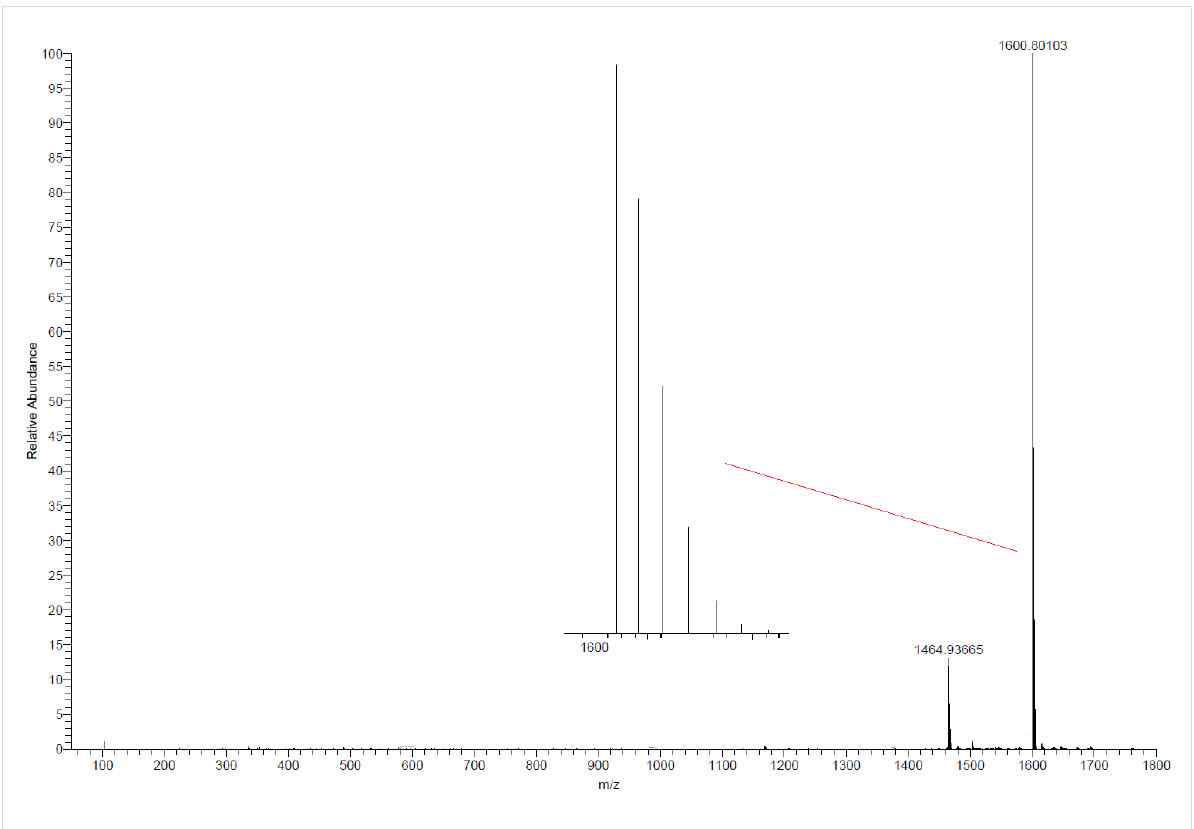
Figure 3: Positive ESI MS of [( 1a )La] in chloroform showing the peaks of {K[( 1a )La]} + (m/z = 1600.8) as well as of {K( 1a -H 3 )} + (m/z = 1464.9). The inset shows the isotopic pattern of the peak at m/z = 1600.8, which corresponds to the one calculated for {K[( 1a )La]} + .